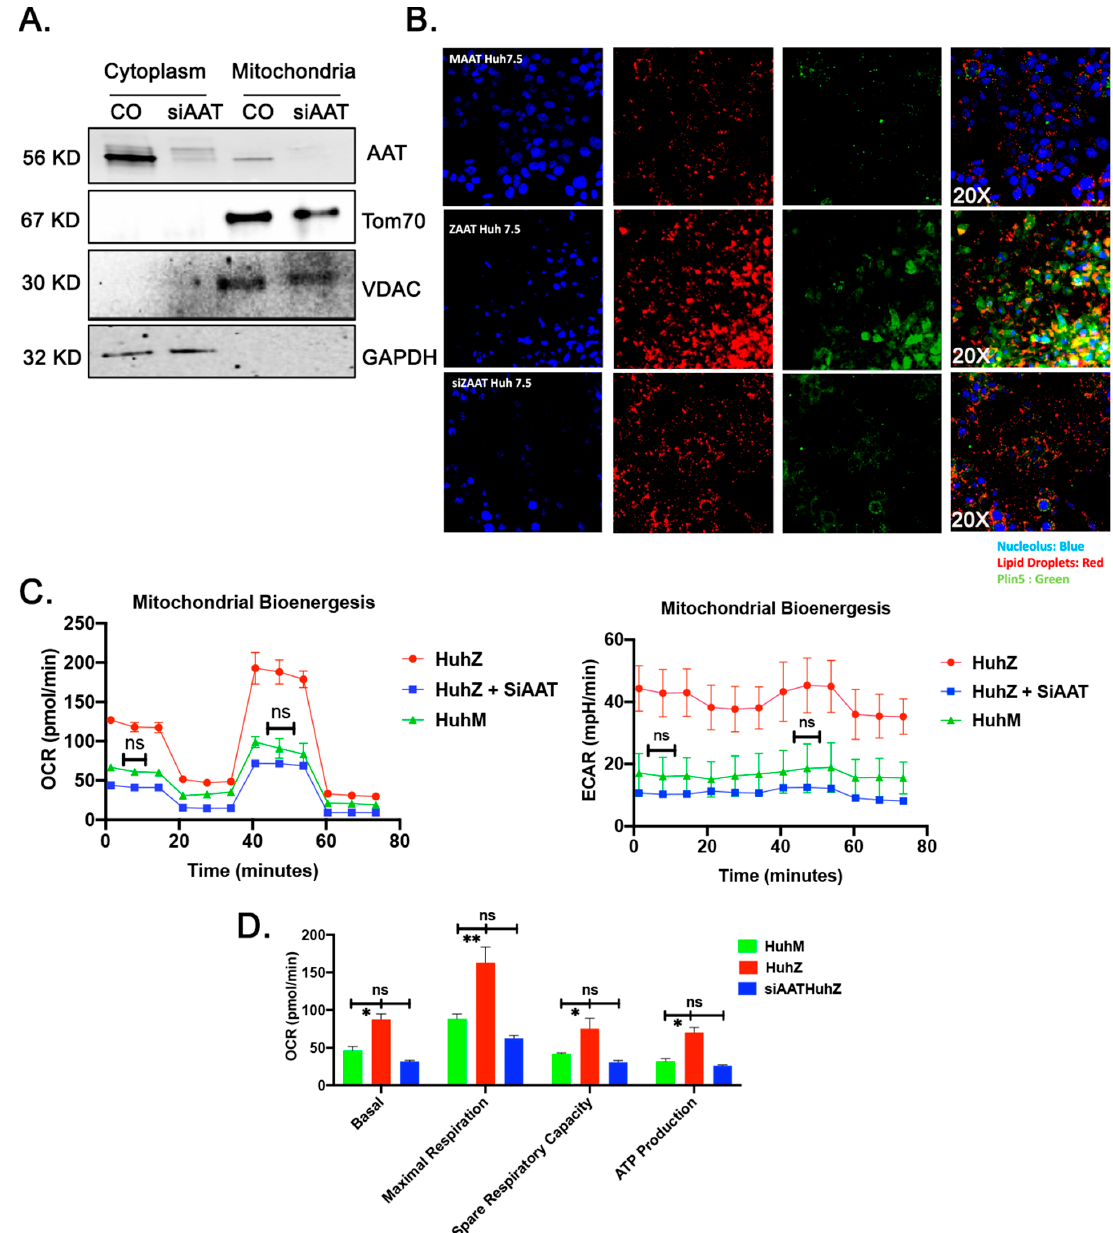
Figure 7. Restoration of the mitochondrial function in ZAAT knockdown hepatocytes. ( A ) Treatment with siAAT clears the ZAAT from the cytoplasm as well as mitochondrial fraction and downregulates the protein levels of Plin5. GAPDH, VDAC, and Tom70 were loaded as cytoplasmic and mitochondrial loading controls. ( B ) Immunofluorescence assay showing the reduction in lipid droplets (red) and Plin5 (green) in siAAT-treated Huh7.5 cells. ( C , D ) Seahorse experiment results showing reduced OCR, ECAR, and ATP production in siAAT-treated Huh7.5 cells compared to control ZAAT-expressing Huh7.5 cells and wild-type (MAAT) Huh7.5 cells. ns nonsignificant, * p < 0.05, ** p < 0.001.